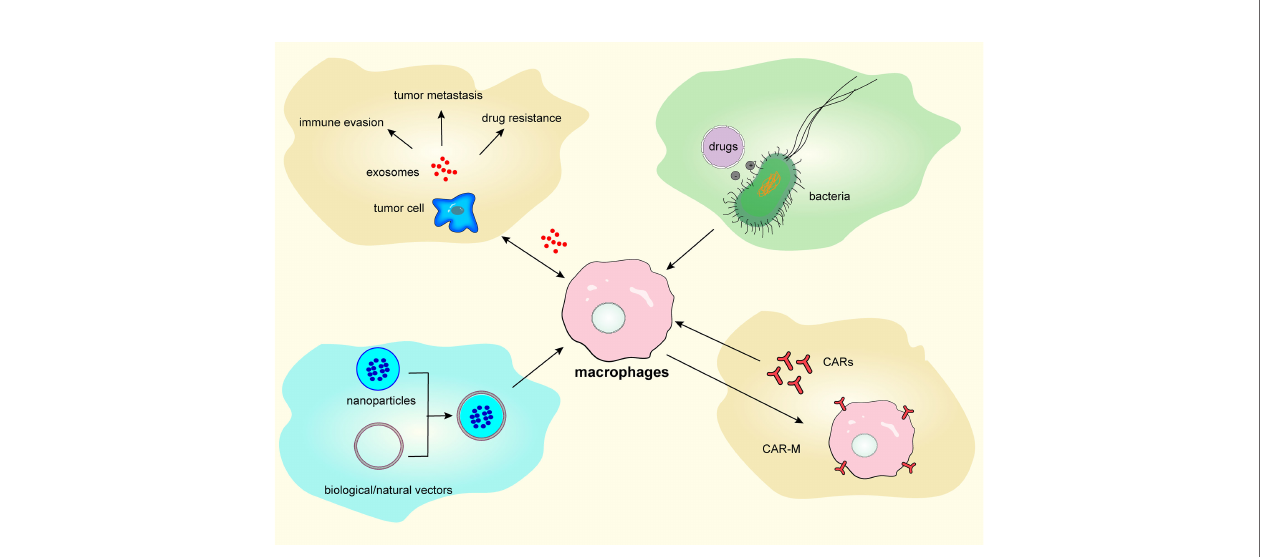
FIGURE 3 | Targeting tumor-associated macrophages repolarization via exosomes, bacterial vectors, nanocarriers, and chimeric antigen receptor-macrophage